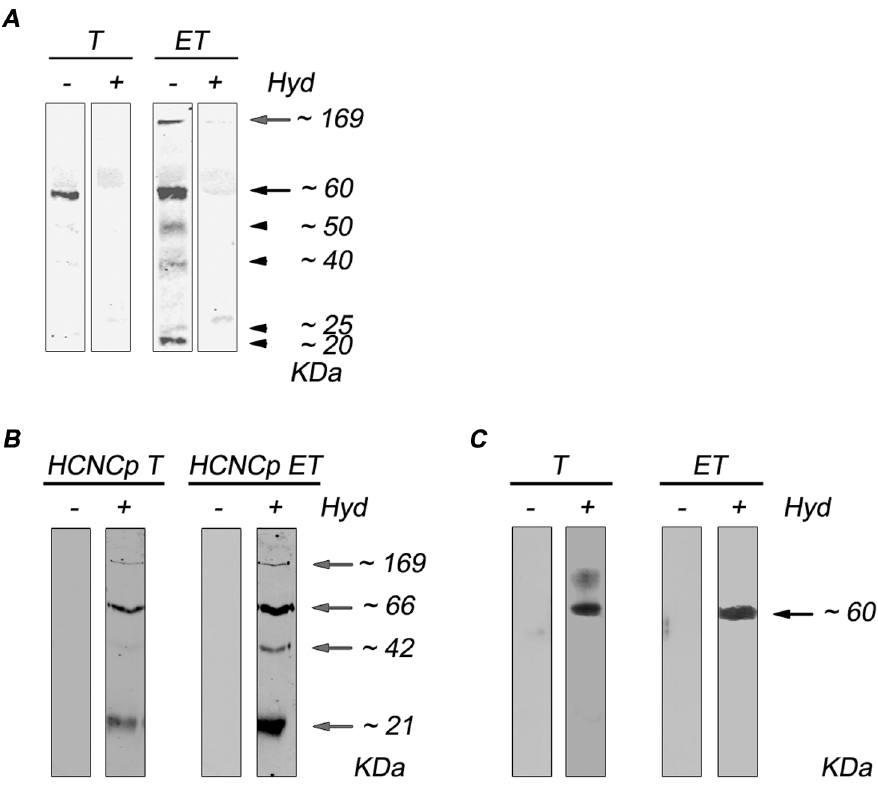
Figure 1. Analysis of S-palmitoylated proteins displays a different pattern in Giardia growing and encysting parasites. (A) Giardia trophozoites (T) or encysting trophozoites (ET) were labeled with [ 3 H]-palmitic acid and loaded onto SDS-PAGE. The gel was treated with (hyd + ) or without (hyd 2 ) the thioester cleavage reagent hydroxylamine. Samples were then analyzed by autoradiography. (B) Western blotting performed on palmitoylated proteins purified by ABE from hcncp-V5 transgenic trophozoites (HCNCp T) or hcncp-V5 transgenic encysting trophozoites (HCNCp ET). (C) Western blotting performed on palmitoylated proteins purified by ABE from wild-type trophozoites (T) or encysting parasites (ET). The approximate sizes are indicated on the right in kDa.